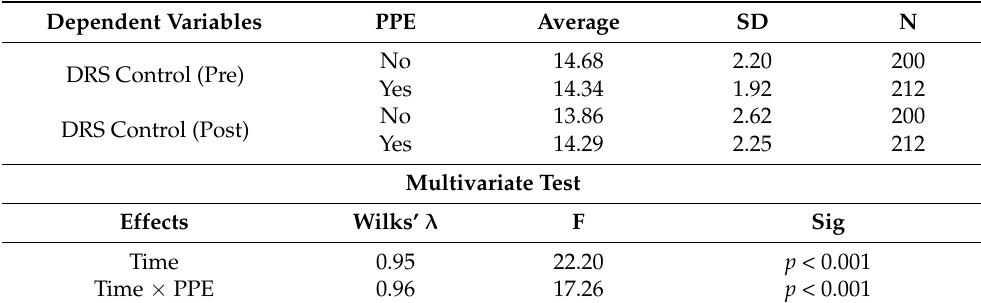
Table 11. Repeated measures ANOVA model of time (i.e., pre- and post-pandemic first-wave effect) and PPE effects on control hardiness.